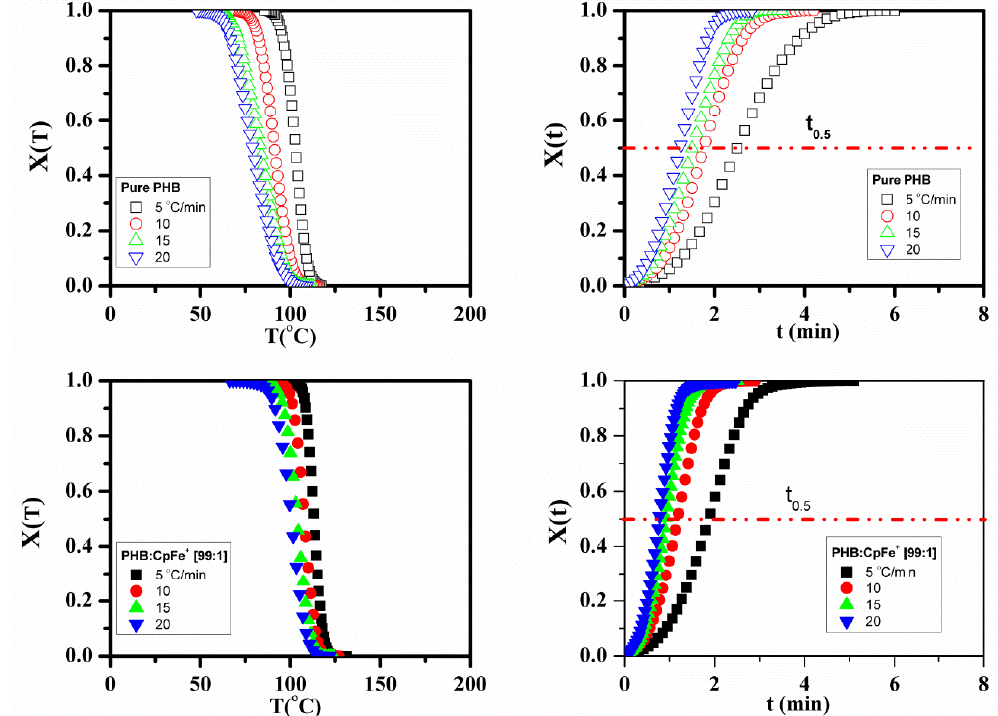
Figure 8. Relative crystallinity as a function of crystallization temperatures and time in the non-isothermal crystallization process for the pure PHB and PHB/CpFe + nanocomposites at various cooling rates.